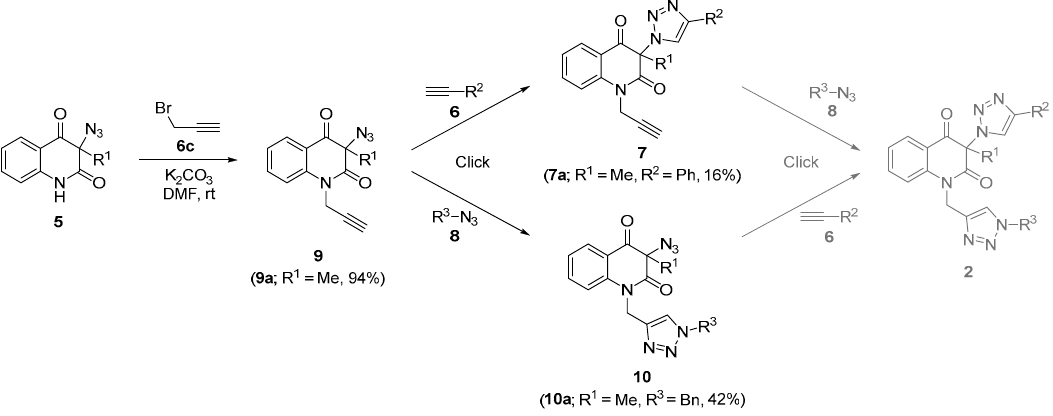
Scheme 3. An alternative approach to bis(1,2,3-triazole) functionalized quinoline-2,4-diones 2 through a “propargylation-click-click” reaction sequence.